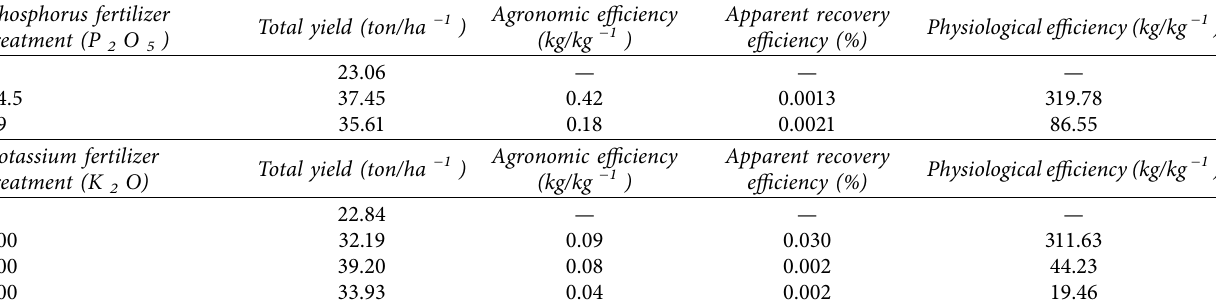
Table 6: Nutrient use efficiency of potato crops for the main effects of phosphorus and potassium fertilizers. Phosphorus